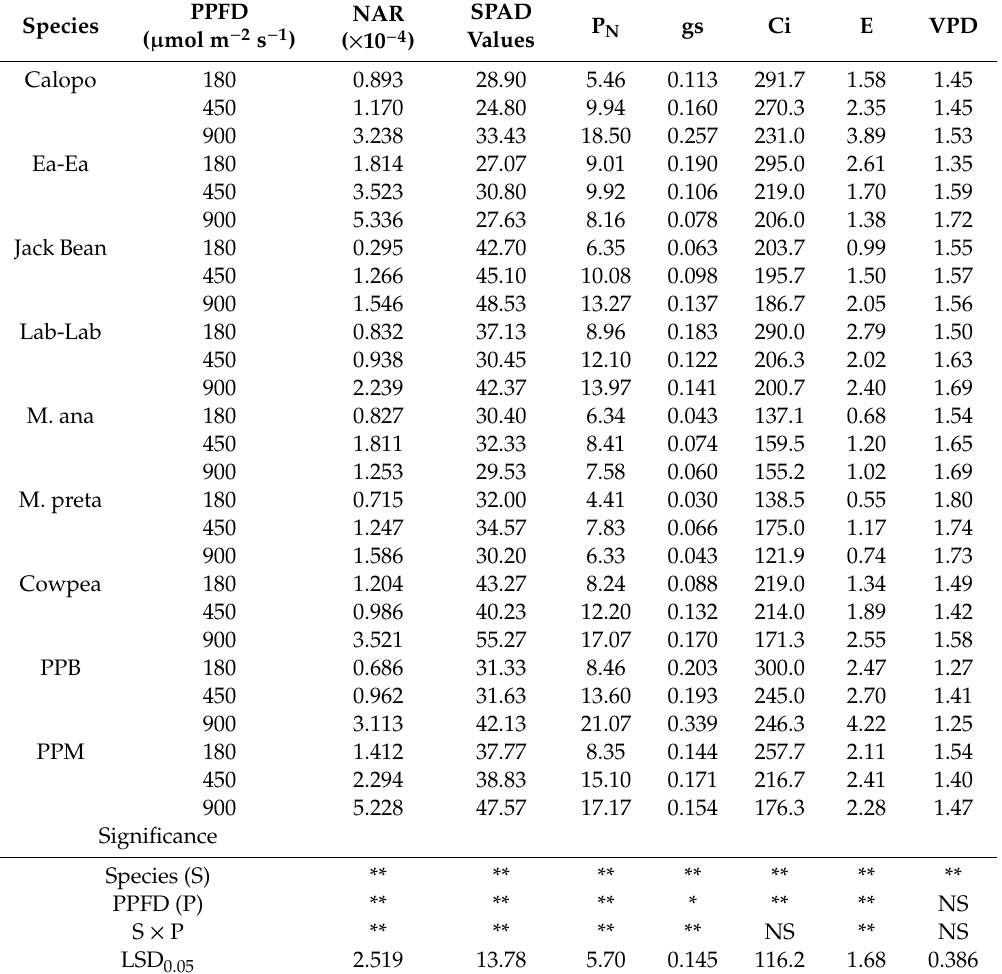
Table 3. E ff ect of photosynthetic photon flux density (PPFD) on physiological parameters in cover crops.